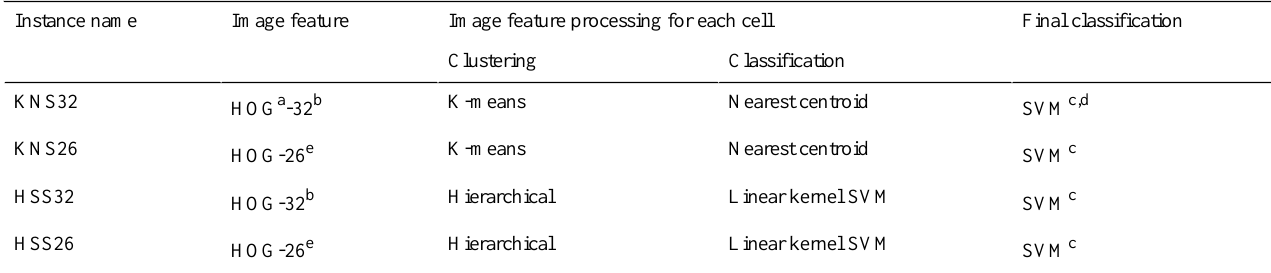
Table 2. The 4 instances of the proposed histogram-based morphometry framework used for performance